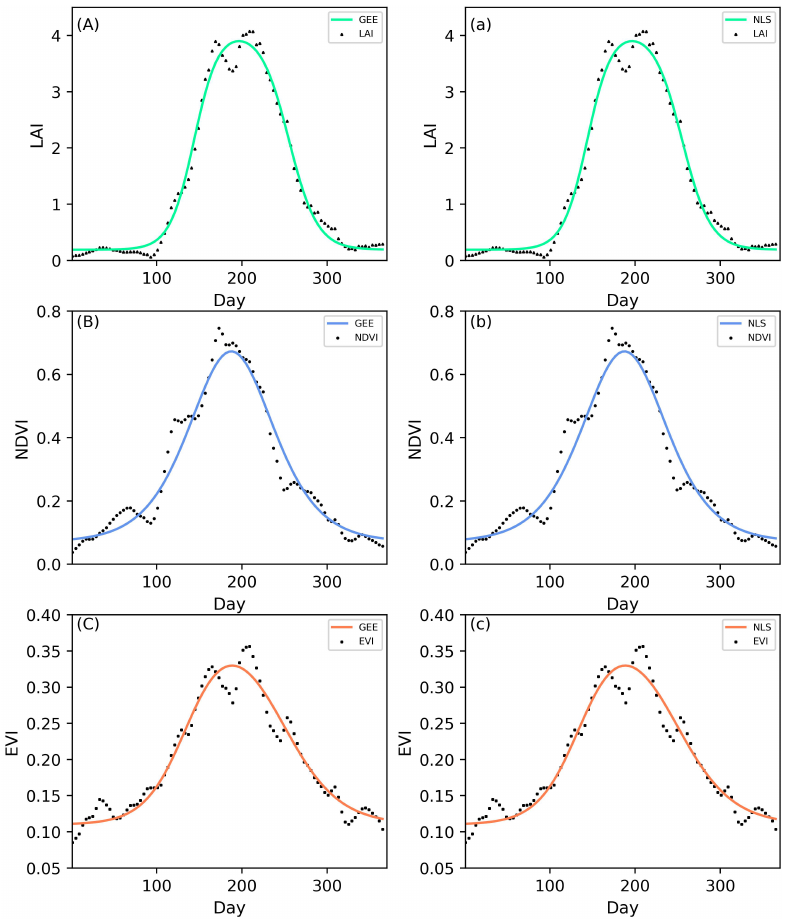
Figure 3. Comparison of the observations and fitting equation by the GEE-based LM method and NLS method.(Fitting the double logistic model using the LAI data on the GEE platform ( A ) and the NLS method ( a ),using the NDVI data on the GEE platform ( B ) and the NLS method ( b ),using the EVI data on the GEE platform ( C ) and the NLS method ( c